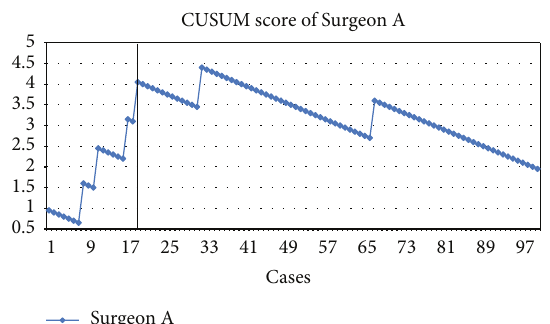
Figure 4: CUSUM analysis of learning curve of Surgeon A.